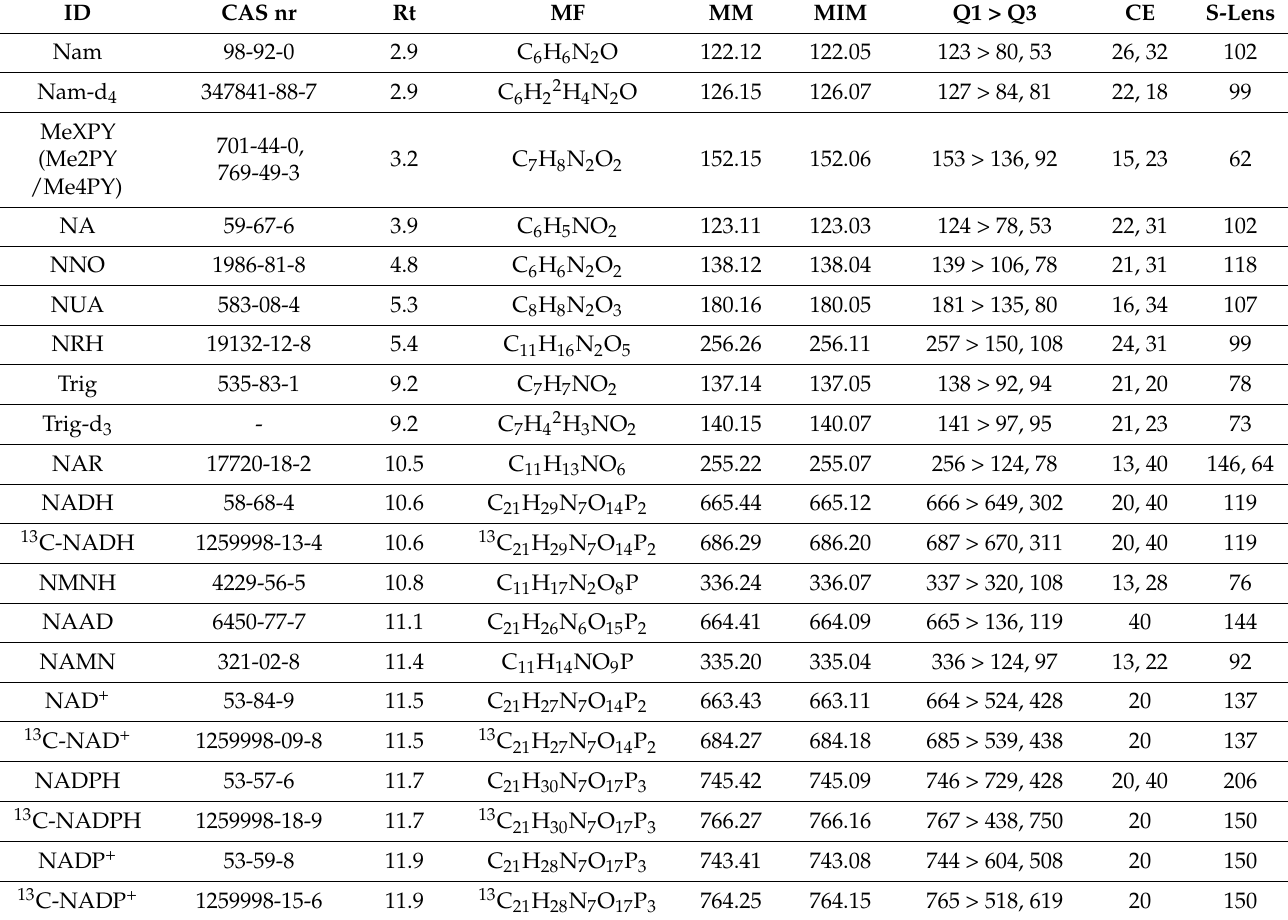
Table 1. Metabolites and LC-MS/MS settings of the NAD + metabolome